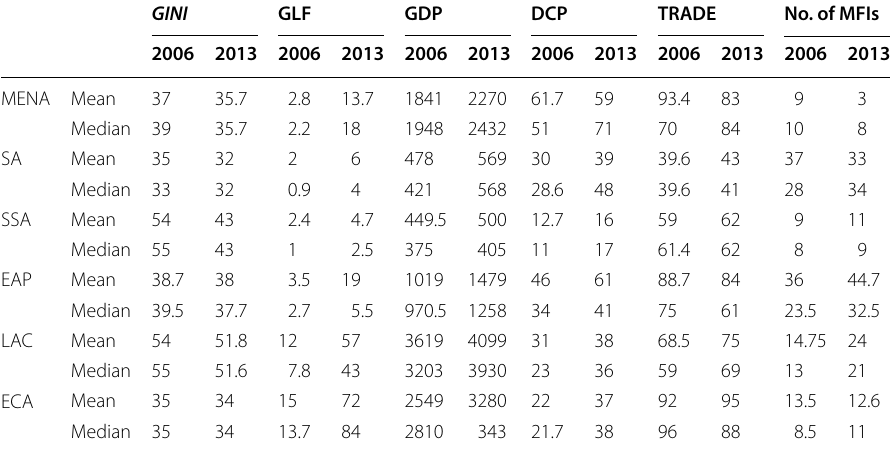
Table 1 Summary